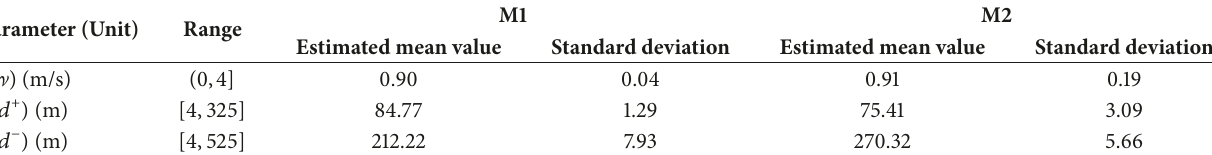
Table 5: Indicators’ mean values in M1 and